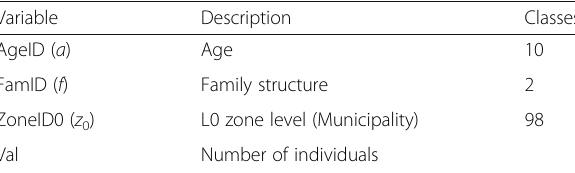
Table 7 Target T af ( z 0, a , f ) for age, family structure and municipality level